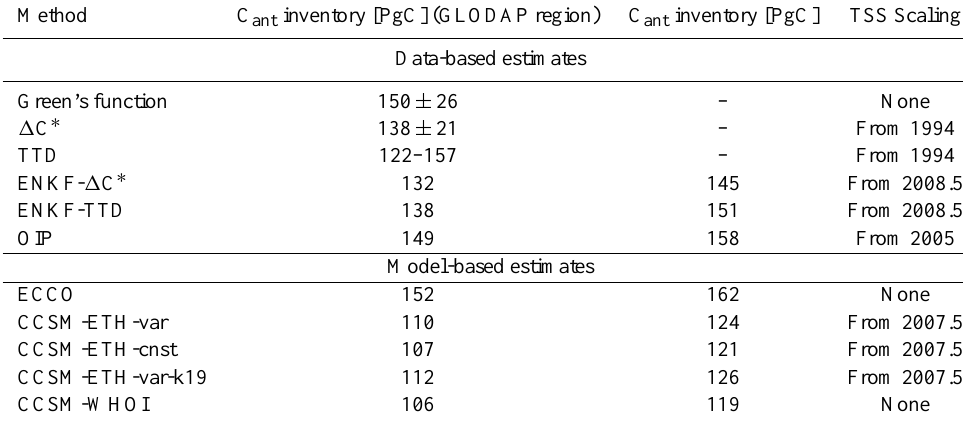
Table 2. Summary of C ant inventories in 2010 (mid-year or annual mean) estimated by different observational methods and simulated in numerical models. Inventories for both the region covered by the GLODAP database (second column) and (for estimates involving models) the original grid (third column) are shown. In some instances the estimate has been scaled from the original year of reference to 2010 using the transient steady state (TSS) approach (see text), as indicated in the fourth